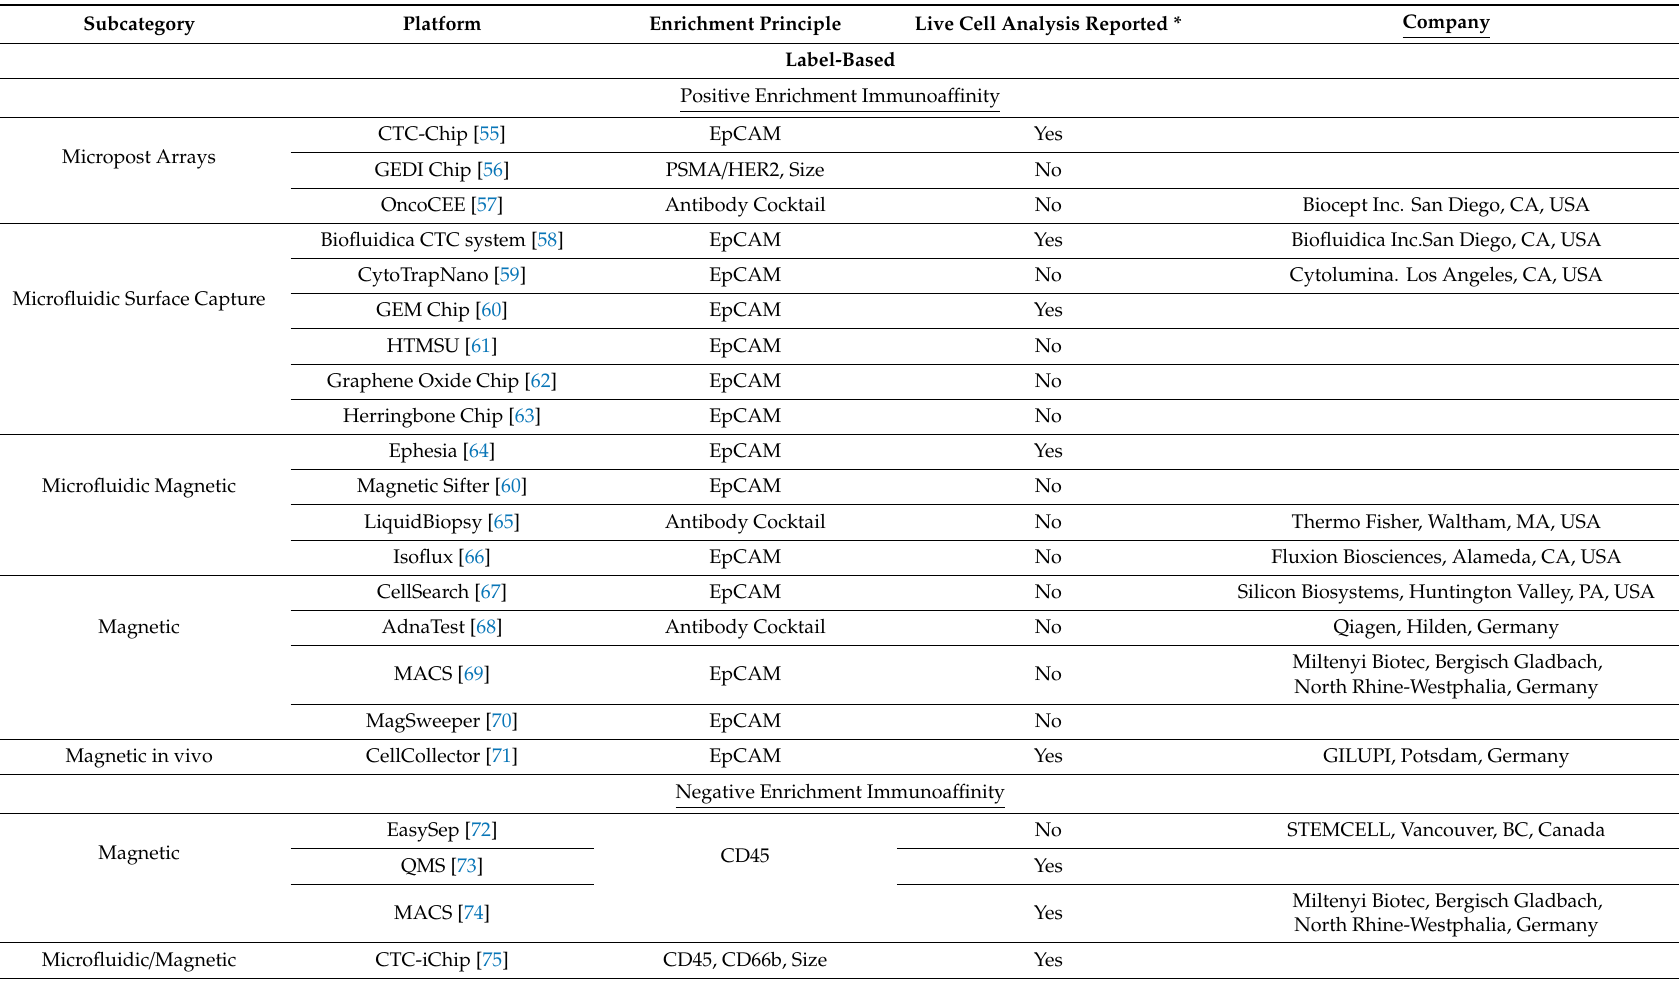
Table 1. Circulating tumor cell (CTC) technologies. CTC isolation technologies grouped by category and isolation criteria. Modified from Ferreira et al. 2016 [54]. *refers to the reference in